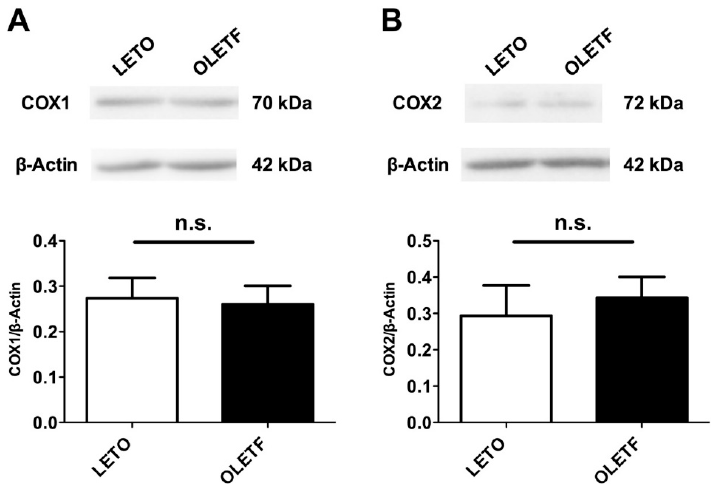
Figure 5. Protein expression of cyclooxygenase (COX)1 ( A ) and COX2 ( B ) in aortas obtained from LETO ( n = 6) and OLETF ( n = 6) rats. Each column represents means ± standard errors. LETO, Long-Evans Tokushima Otsuka rats; OLETF, Otsuka Long-Evans Tokushima fatty rats; n.s., not significant.